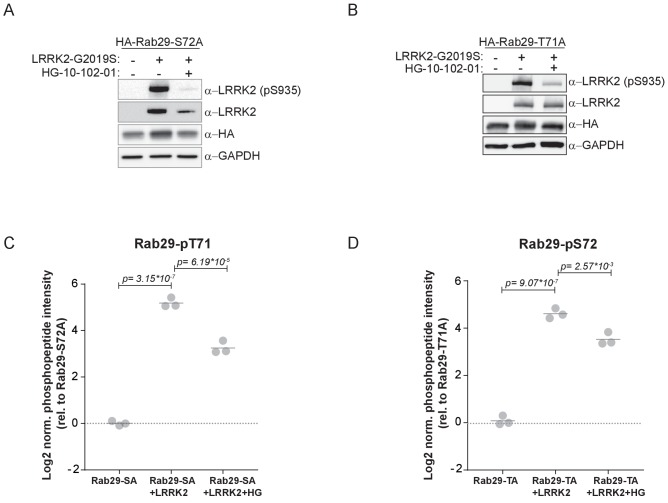
Both Rab29-T71 and Rab29-S72 are phosphorylated by overexpressed LRRK2 in HEK293 cells.(A) Western blot of HA-Rab29-S72A and (B) HA-Rab29-T71A expression in HEK293 cells.(C) MS-quantified Rab29-pT71 and (D) Rab29-pS72 phosphopeptide intensities of overexpressed proteins in HEK293 cells.